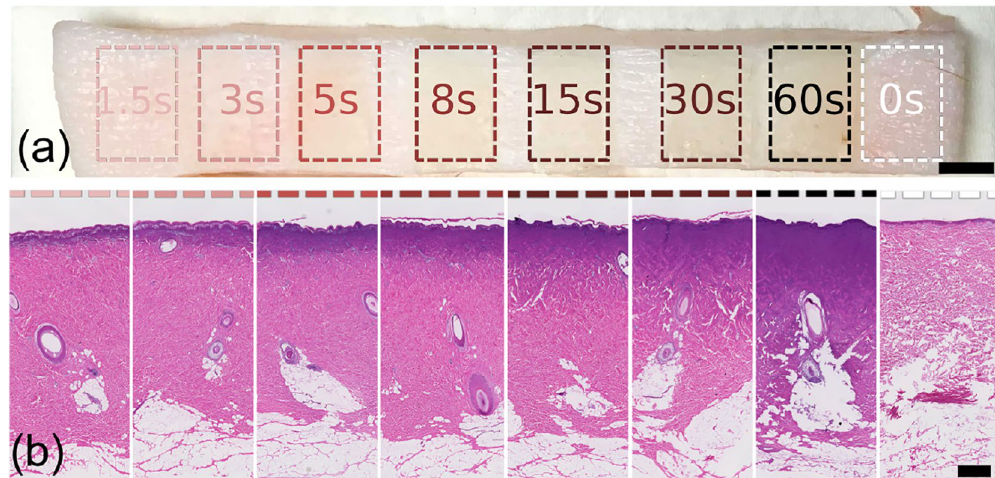
Figure 1. Visual overview of superficial appearance of induced burn wounds by eye ( a ) and upon evaluation with hematoxylin and eosin (H&E) histology ( b ). The colors of the dashed lines here and in subsequent figures correspond to the duration of burn for a given tissue region. Scale bars = 0.5